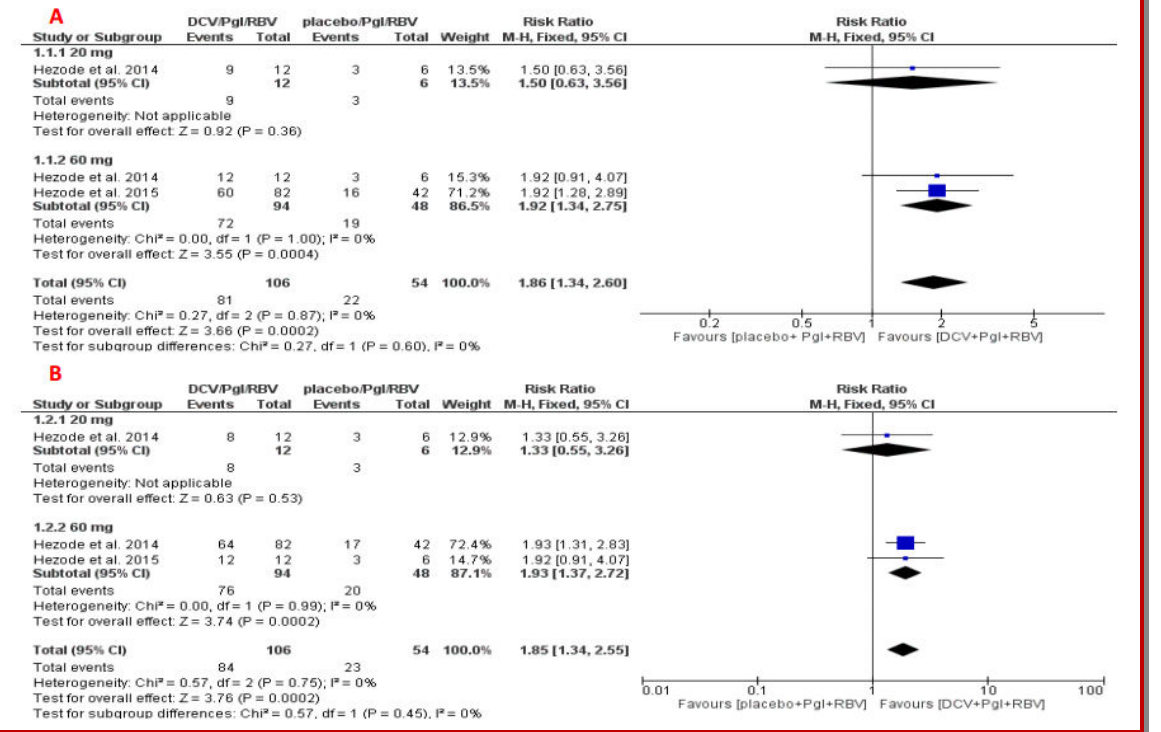
Figure 3: Forest plots comparing the dual and triple regimens in terms of relapse rate (A) and rapid virologic response rate